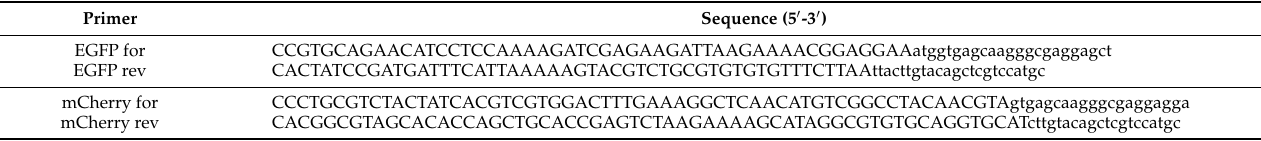
Table 2. Primers used for generation of the dual fluorescent virus TB40-BAC-KL7-SE-UL32EGFP-UL100mCherry.